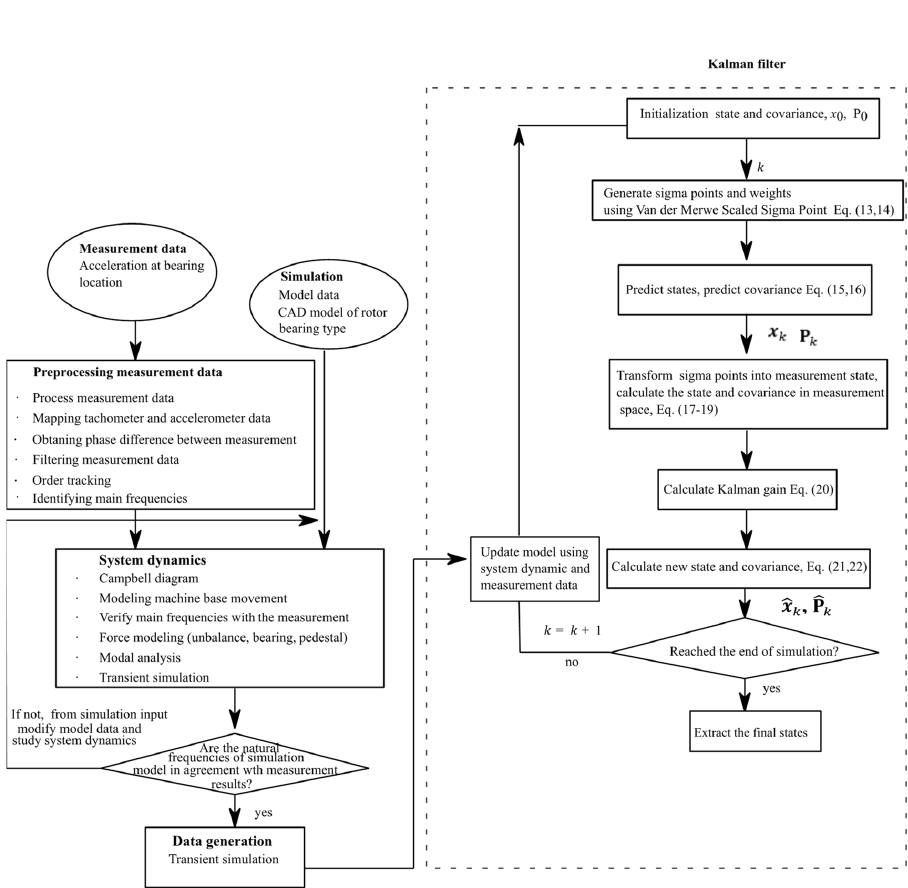
Figure 1. Flowchart of the process to utilize Kalman filter with the rotor dynamics model.